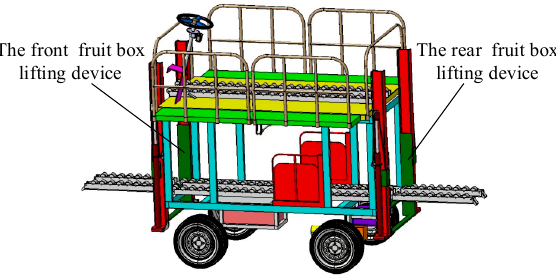
Figure 8. Installation diagram of the fruit-box-lifting device.